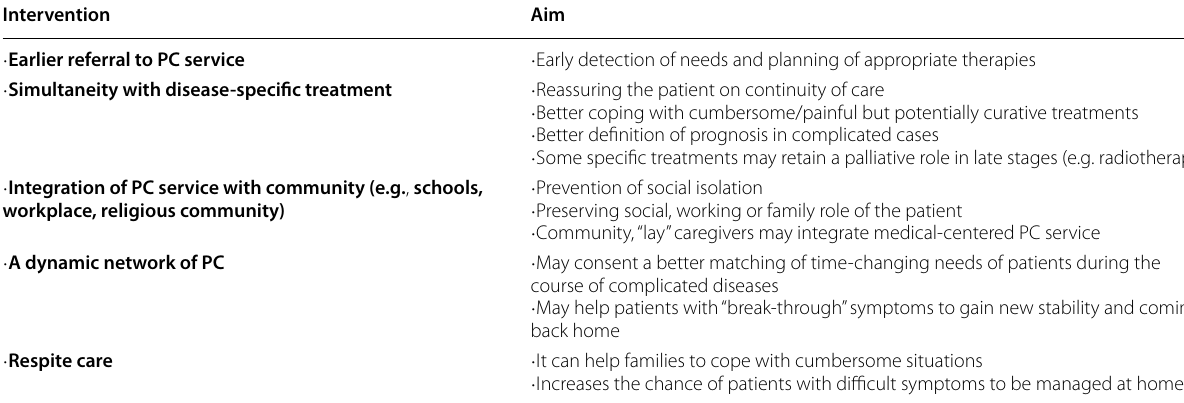
Table 2 Interventions which are typical of PPC that can implemented within APC service Intervention Aim